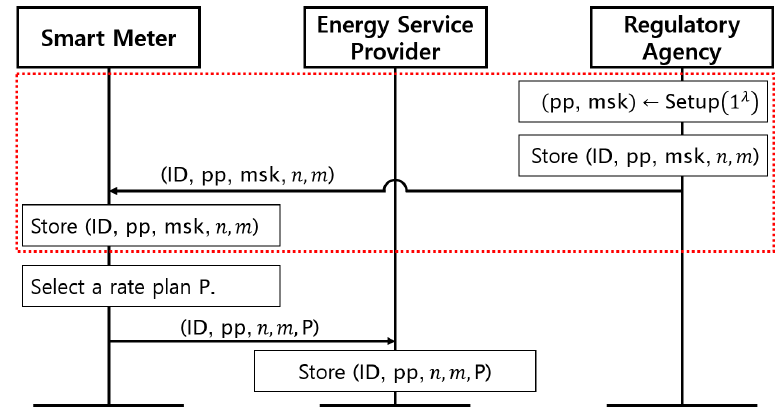
Figure 2. Registration stage of our